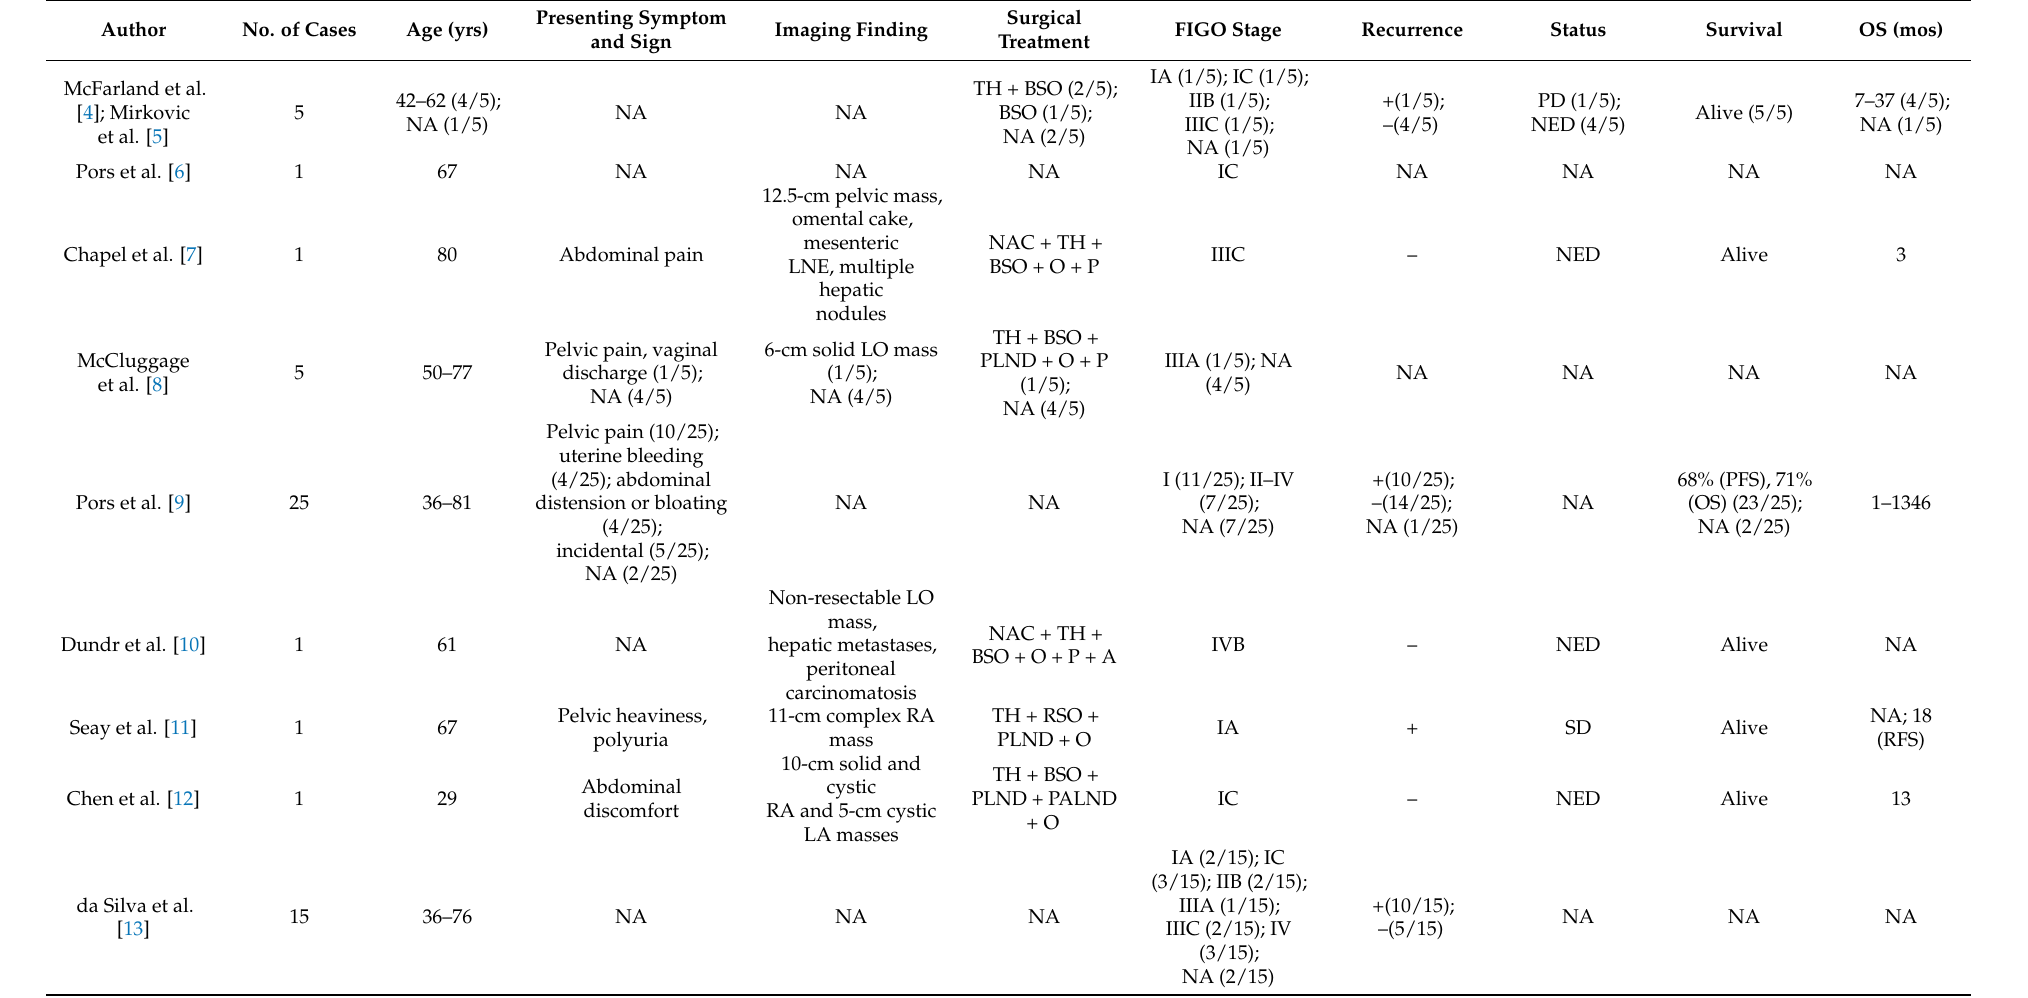
Table 5. Clinical features of previously published cases of ovarian mesonephric-like